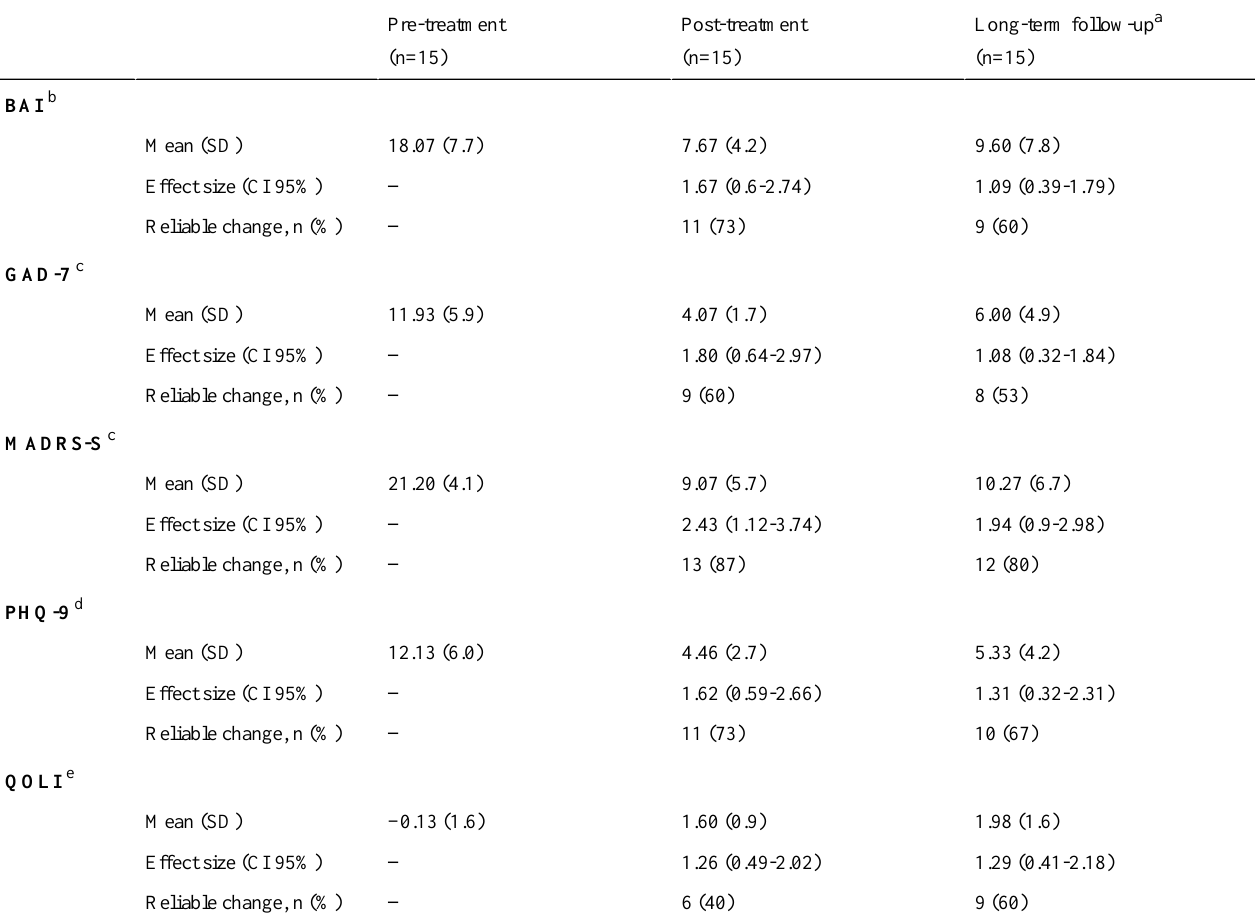
Table 4. Mean, SD, effect size, and reliable change index at pre-treatment, post-treatment, and at long-term follow-up to treatment.